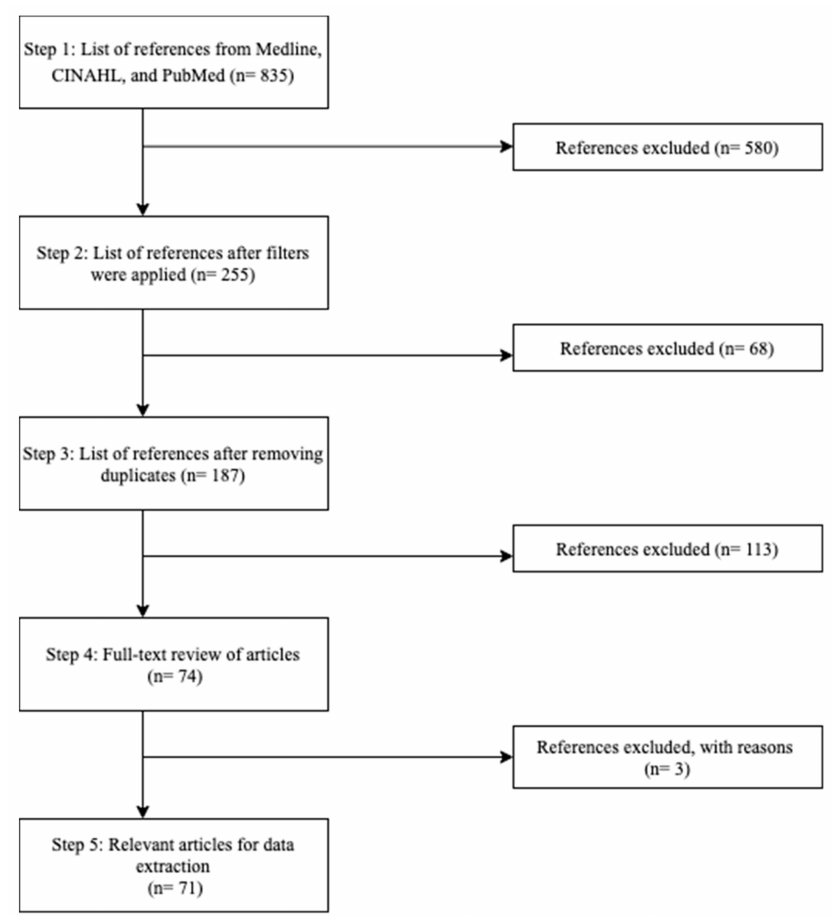
Figure 1. Flowchart depicting the steps taken to identify the relevant articles to be used for data extraction in our scoping